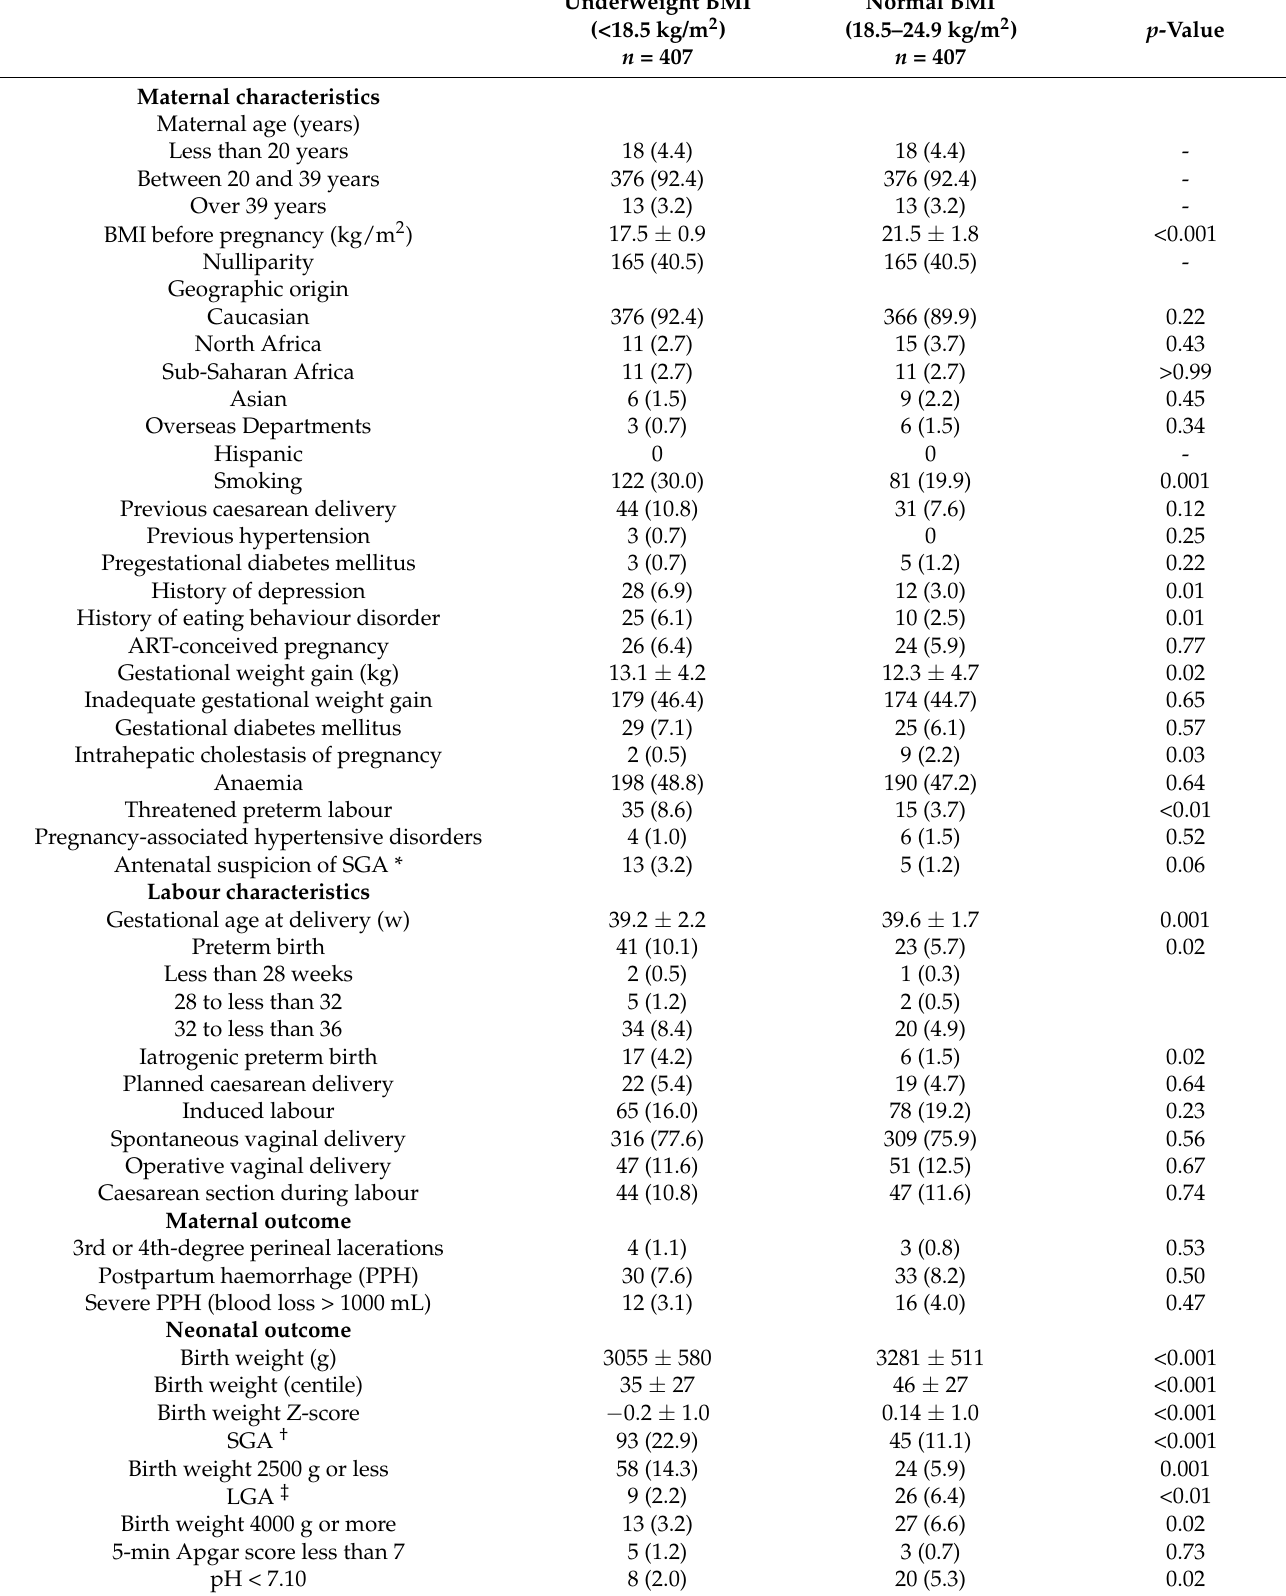
Table 1. Maternal and labour characteristics and maternal and neonatal outcomes according to the prepregnancy